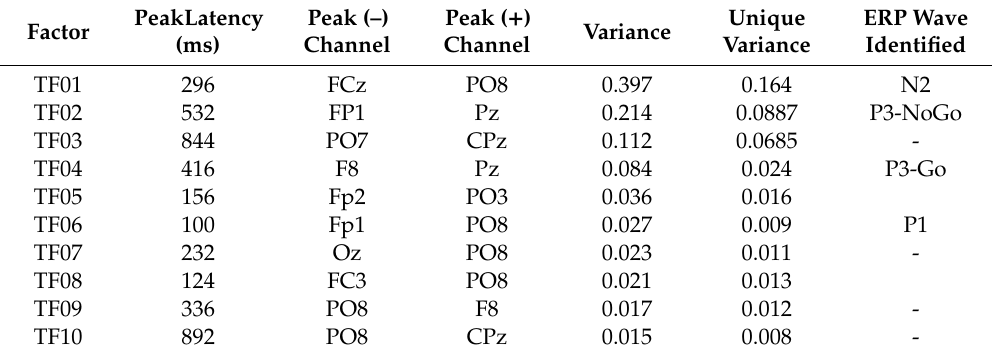
Table 3. Temporal PCA factors: All of the factors identified are ordered by the explained variance, with their latency (ms) and maximum negative and positive locations (absolute maximum in bold). The factors with the event-related potential (ERP) components of interest for the study are included in the final column.